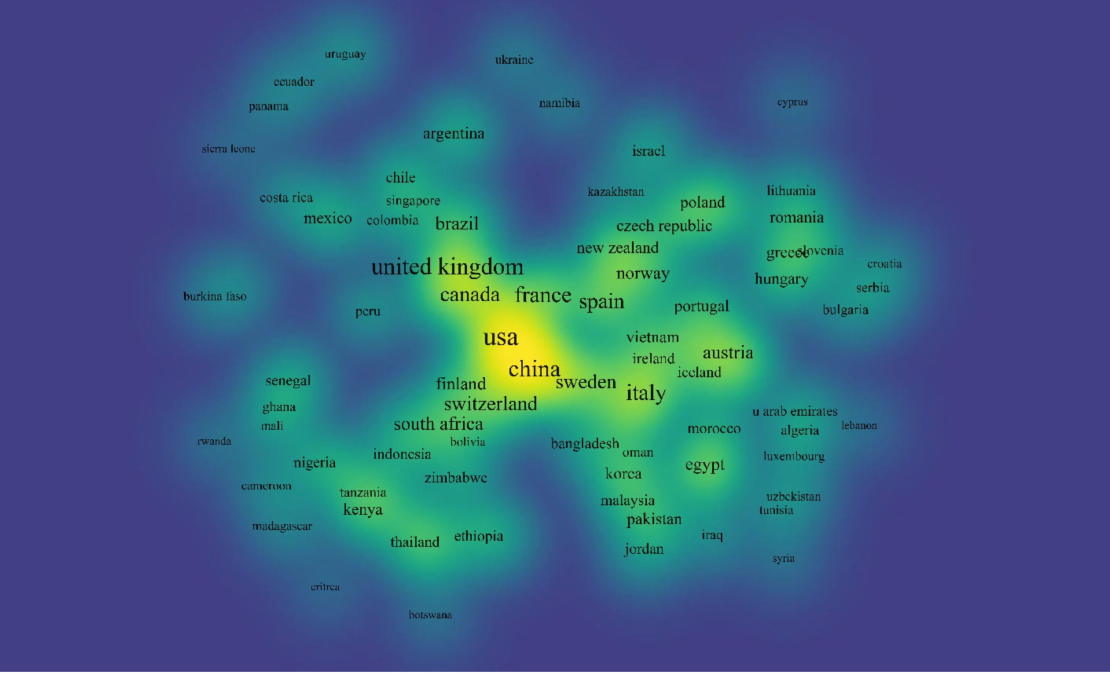
Figure 5. Map showing research collaboration between